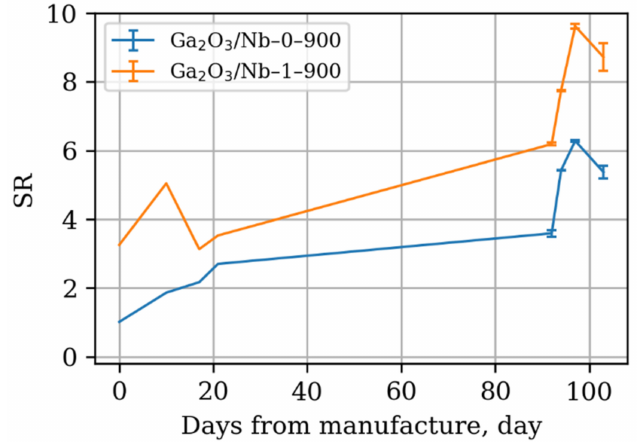
Figure 13. Dependence of sensor response of Ga 2 O 3 -based materials at fixed working temperature 470 ◦ C towards acetone 20 ppm in dry air at different days after manufacturing and start of gas sensor response